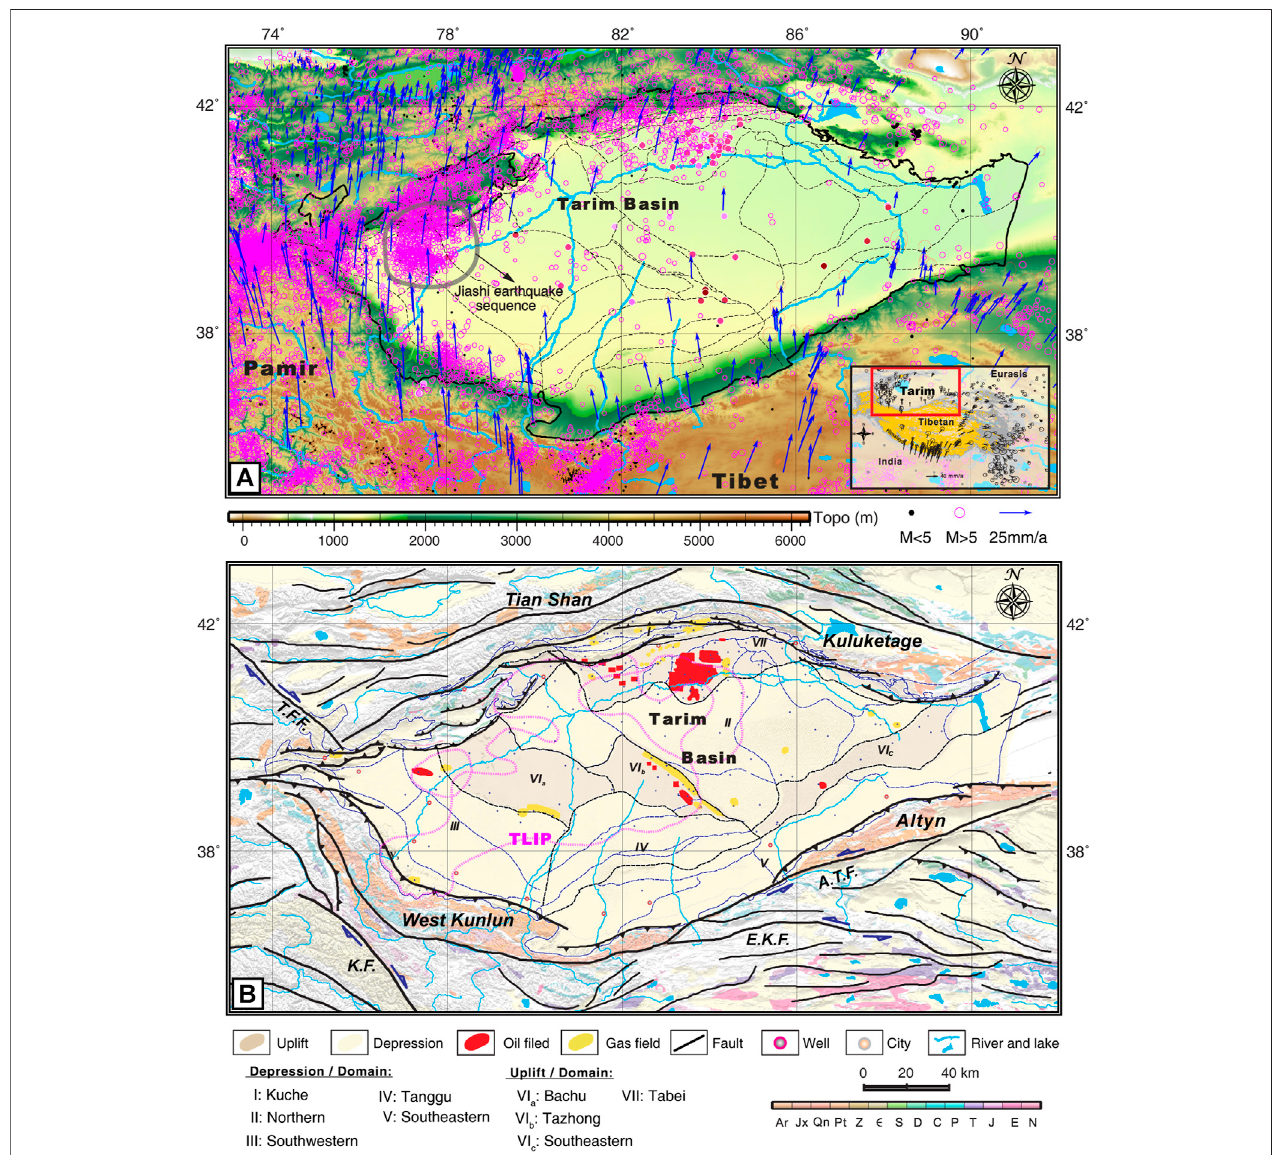
FIGURE 1 | (A) Topography of the Tarim Basin and its environs. Inset map shows the location of study area. The black and purple circles represent earthquakes from 1964 to 2016, from the ISC data base (http://www.isc.ac.uk/). The blue arrows represent GPS velocities relative to Siberia (Zheng et al., 2017). The black line outlines the Tarim Basin, within which the dashed black lines are the boundaries of subdomains corresponding to basinal structural units marked and named as in the legend, and the red lines are major faults (B) Tectonic map of the Tarim Basin and its environs. The black lines represent major faults and sutures. These multi- coloredpatchesonthedigitalelevationmodelarechronologicalgeologicalbodiesincludingPrecambrianbasementandigneousrocks,modi fi edfromXJBGMR(1993b), XZBGMR (1993a) and QHBGMR (1991). The purple line represents the Tarim Large Igneous Province (TLIP), modi fi ed from Yang et al. (2007). The yellow patches